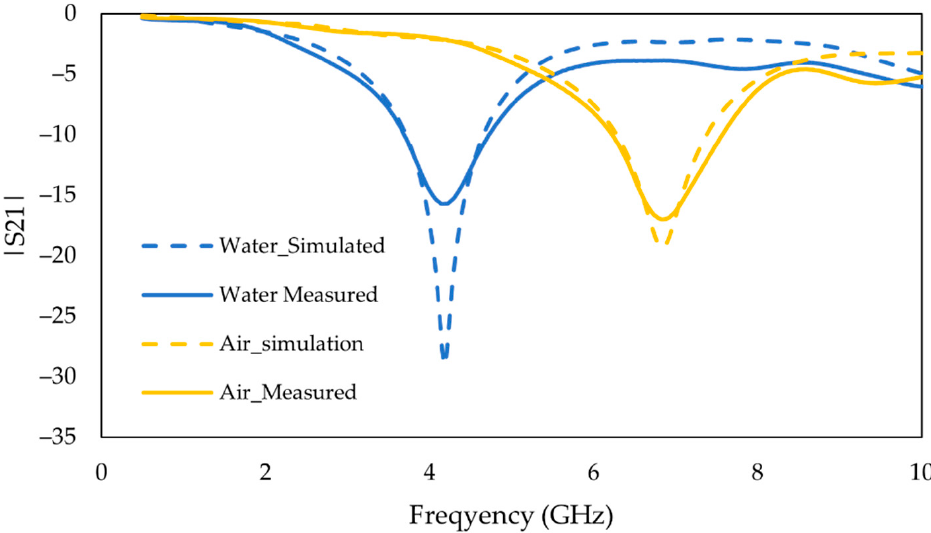
filled with air and DI water.